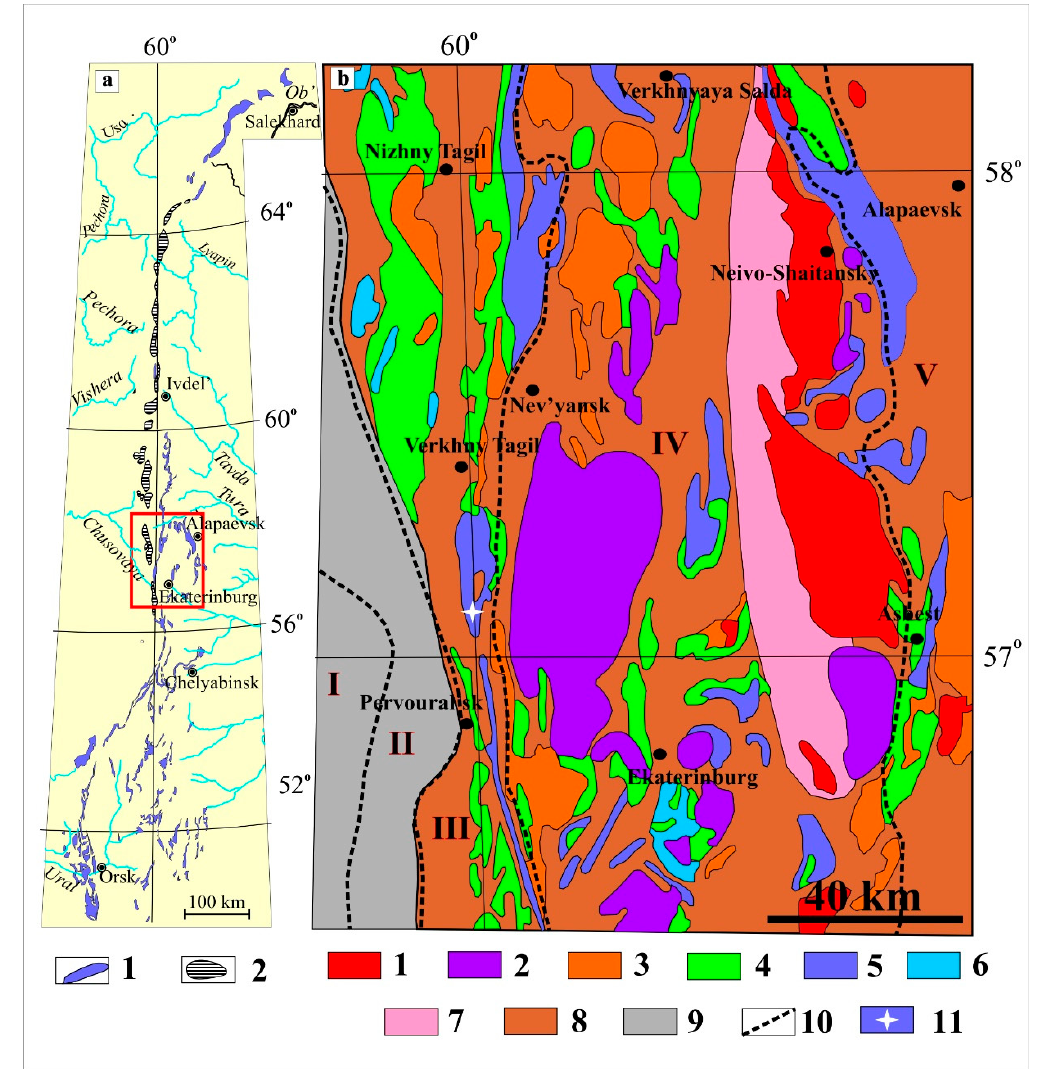
Figure 1. ( a ) Scheme of location of ophiolite- and zoned-type massifs of the Urals. (1) dunite-harzburgite ophiolite-type massifs, (2) dunite-clinopyroxenite-gabbro zoned-type massifs of the Platinum belt. Box corresponds to inset in Figure 1b. ( b ) Tectonic scheme of the Middle Urals and position of the Verkh-Neivinsk massif. (1–6) intrusive formations: (1) granitic (granite, granodiorite, alaskite); (2) granitoid (granodiorite, tonalite, granite); (3) plagiogranitic (plagiogranite, quartz diorite); (4) gabbroic (gabbro, gabbronorite, diorite); (5) dunite-harzburgite (dunite, harzburgite, serpentinite, chromitite); (6) dunite–clinopyroxenite (dunite, chromitite, wehrlite, clinopyroxenite, horblendite); (7) rocks of the amphibolite, amphibolite–gneiss, gneiss, and migmatite associations; (8) volcanogenic sedimentary rocks of the island arc sector of the Urals; (9) flysch, flyschoid, molasse, and terrigenous–carbonate, and carbonate formations of the continental sector of the Urals; (10) boundaries of mega zones ((I) Western Urals, (II) Central Urals, (III) Tagil-Magnitogorsk, (IV) Eastern Urals, (V) Transurals); (11) sampling location.